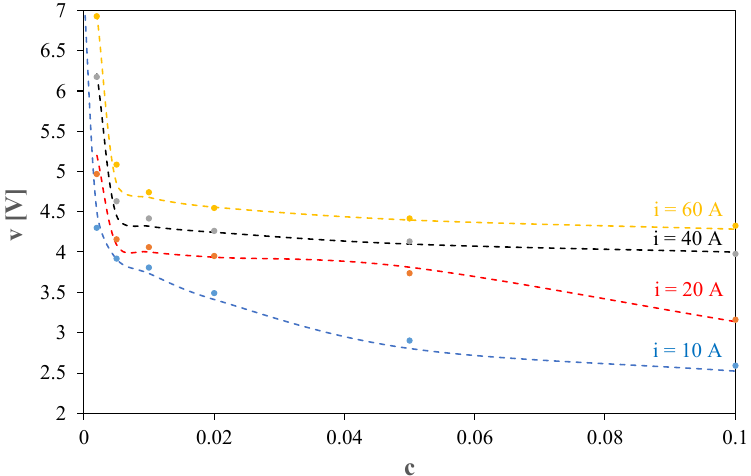
Figure 4. Calculated and measured dependence of the electrolyzer voltage on the electrolyte con- centration.